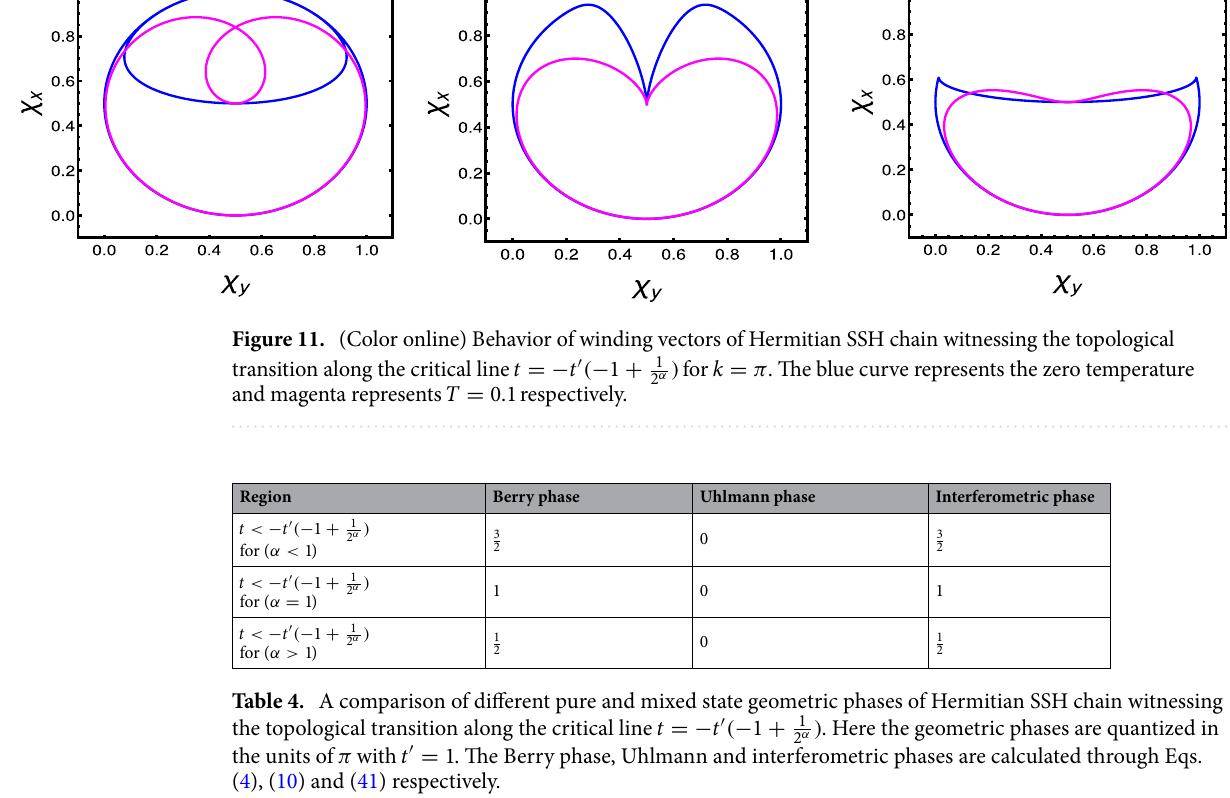
Table 4. A comparison of different pure and mixed state geometric phases of Hermitian SSH chain witnessing 1 t 1 ) . Here the geometric phases are quantized in the topological transition along the critical line t ′ ( − 2 α = − + 1 . The Berry phase, Uhlmann and interferometric phases are calculated through Eqs. the units of π with t ′ = (4), (10) and (41) respectively.